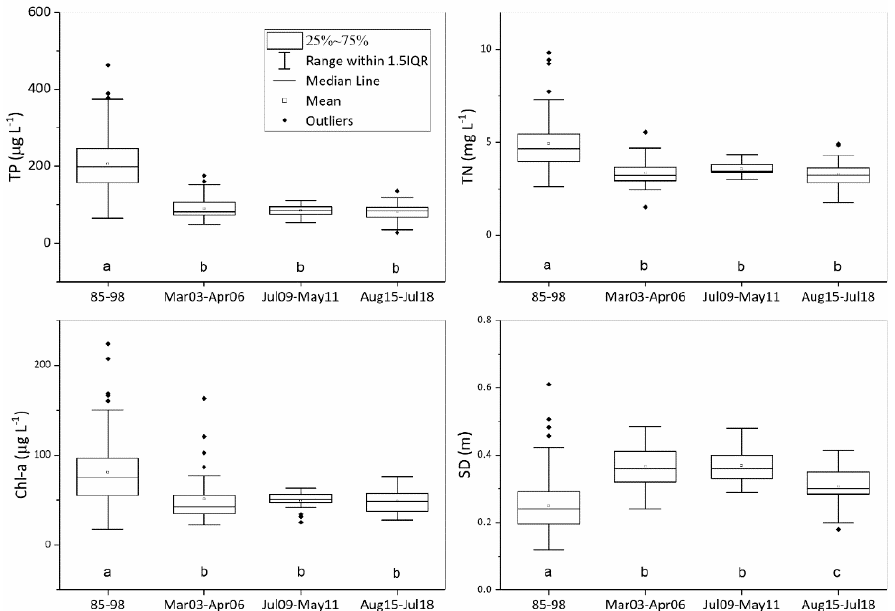
Figure 5. Comparison of water quality in the four wet periods by whisker plots. If one of the letters in one group is the same as the one from the other group, there is no significant difference between these groups. TP: total phosphorus, TN: total nitrogen, chl-a: chlorophyll-a, SD: Secchi transparency.